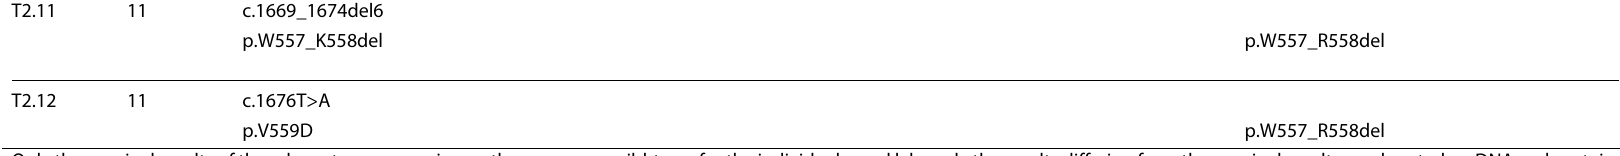
Table 2: Nominal and actual results of the mutation analyses of KIT exons 9 and 11 and PDGFRA exon 18 performed in trial 2.